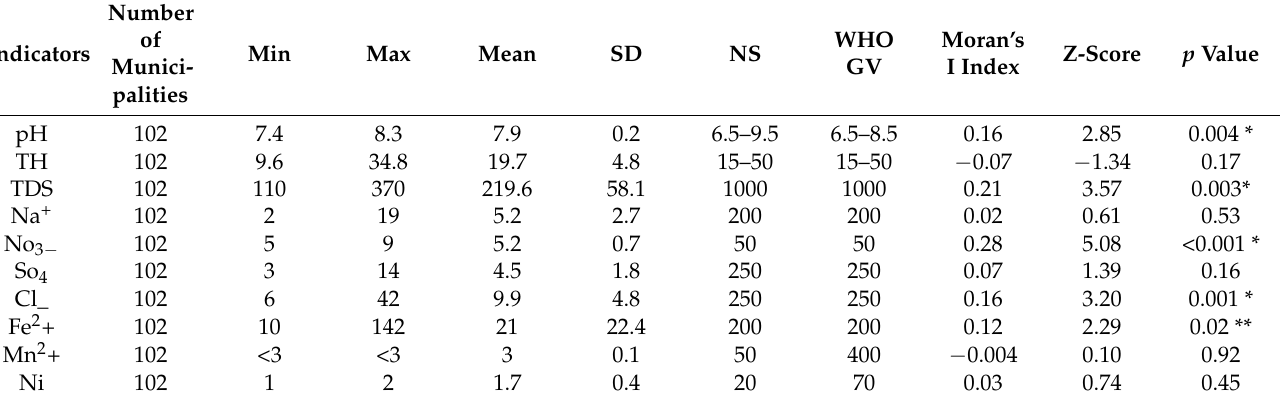
Table 2. Descriptive statistics of the level of element concentration in tap water in Cilento and Global Moran’ s I